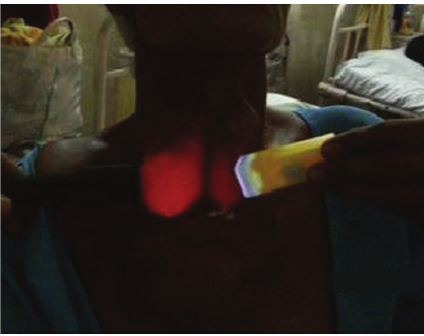
Figure 2: Transillumination of swelling.